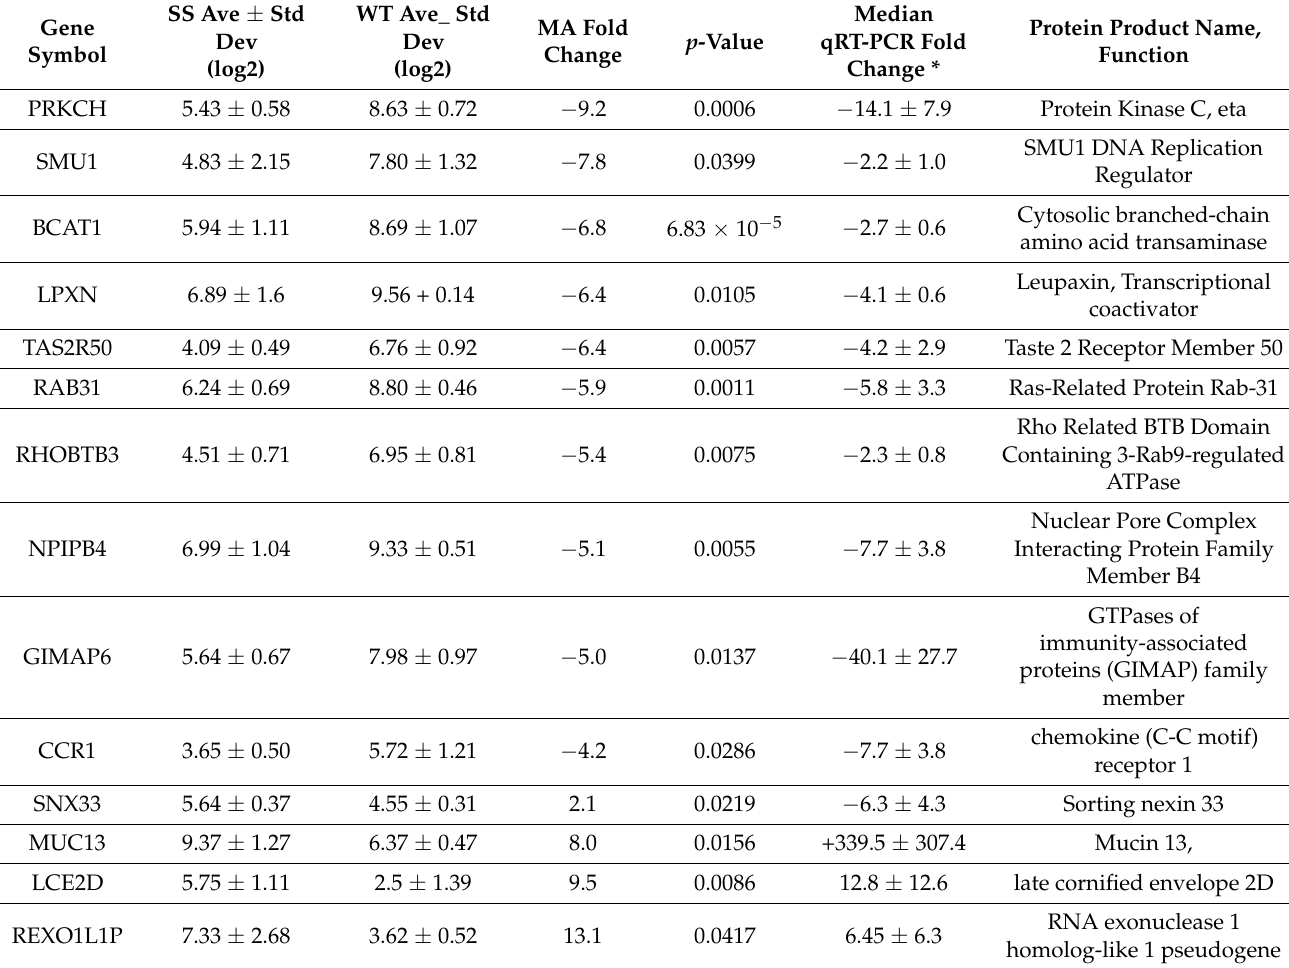
Table 2. Selected genes showing differential hybridization results in Setleis versus control human lymphoblasts. Gene